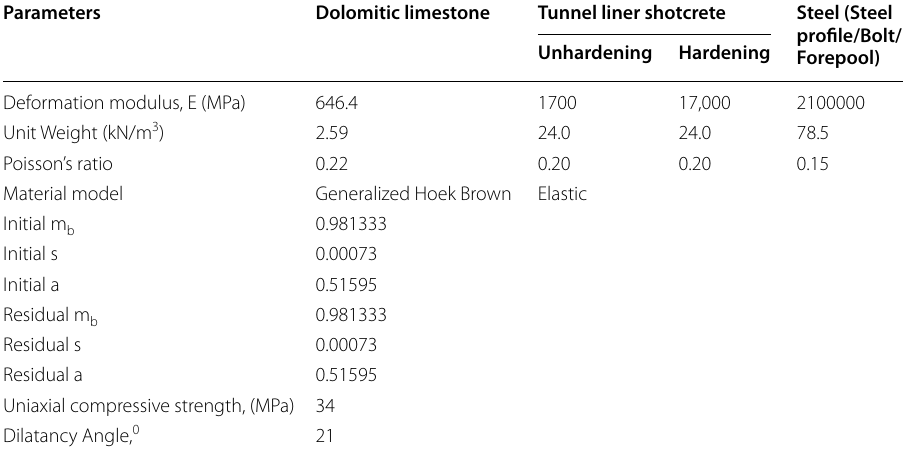
Table 3 Material parameters used in the numerical analysis [22, 46]